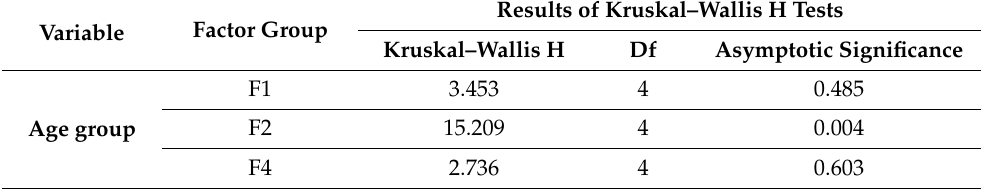
Table 7. Results of Kruskal–Wallis H test. Source: composed by the authors by using IBM